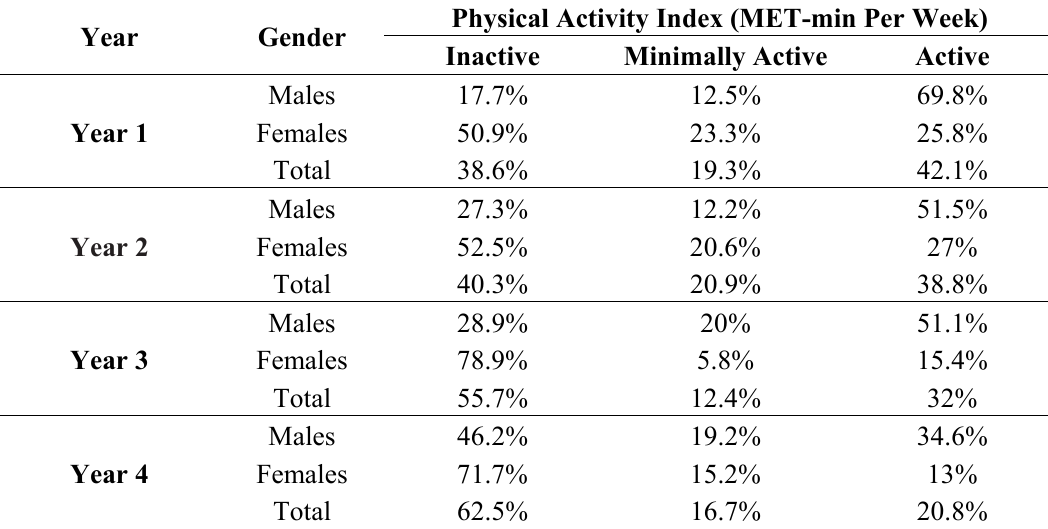
Table 2. Levels of physical activity across study Years 1–4.